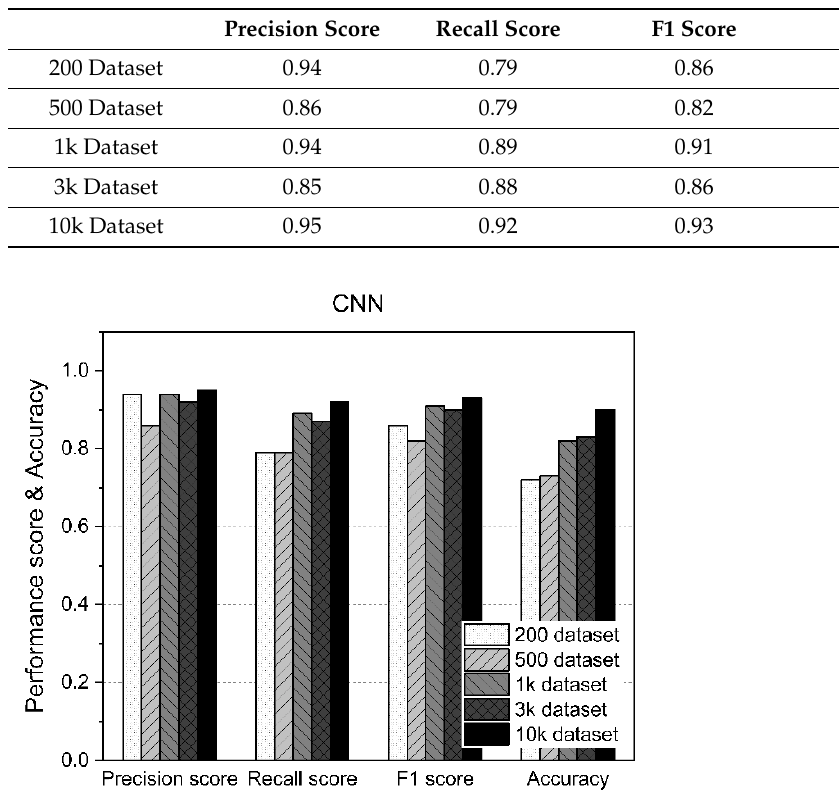
Figure 11. CNN performance results according to the size of the dataset.